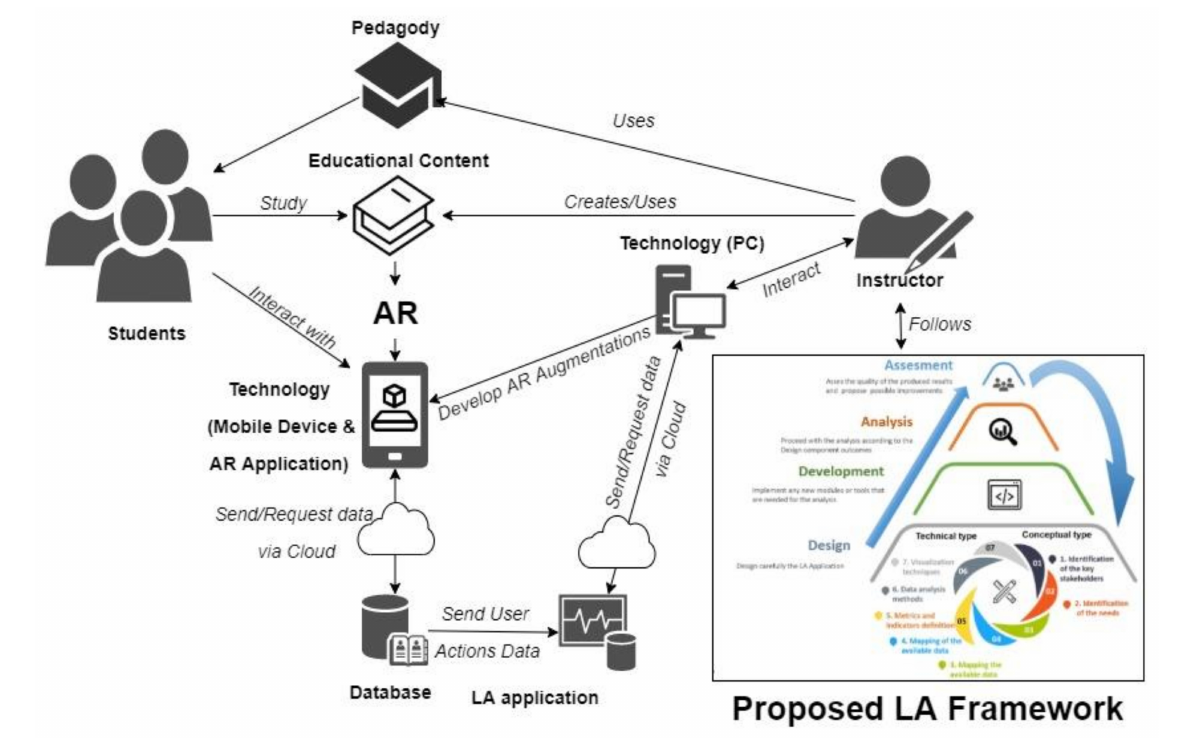
Figure 2. Implementation of the LA Framework for augmented reality (AR)-supported